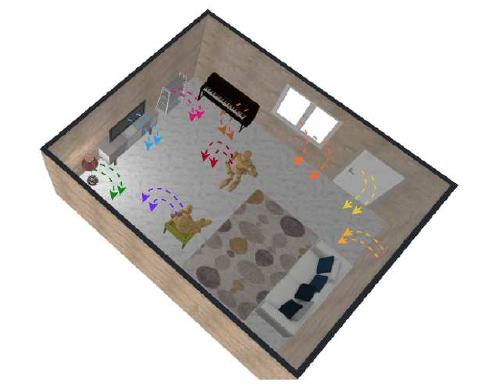
Figure 10. Human body capacitance: the static electric field between the body and the